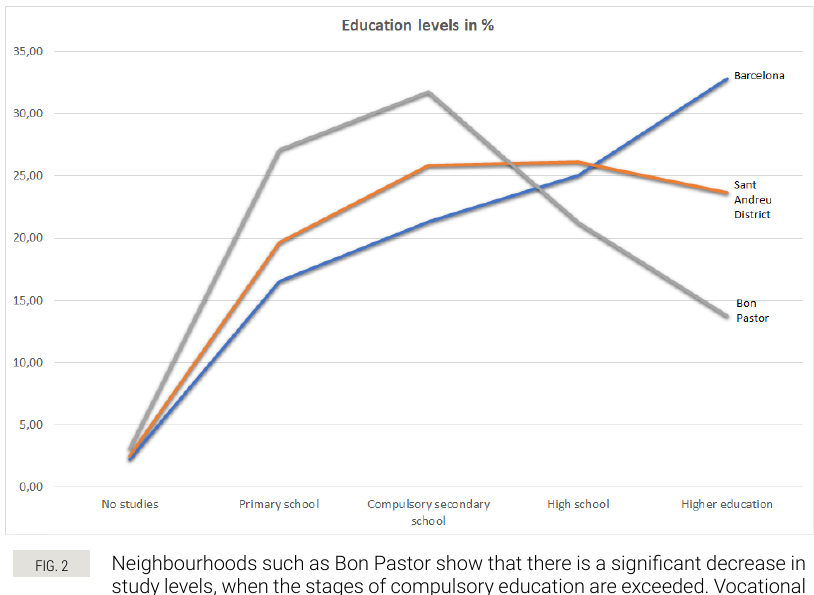
FIG. 2 Neighbourhoods such as Bon Pastor show that there is a significant decrease in study levels, when the stages of compulsory education are exceeded. Vocational and university education policies do not have the necessary mechanisms (free of charge, scholarships, etc.) to ensure universal access to all levels of